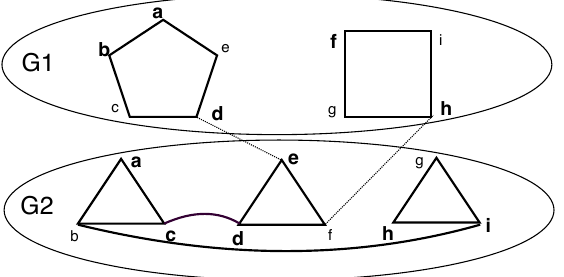
Figure 3. MVC: The vertices of a minimum vertex cover are { a , b , d , f , h } from G 1 and { a , c , d , e , h , i } from G 2 . The cardinality of any MVC of G is 11. The vertices of MVC are shown in larger bold font.